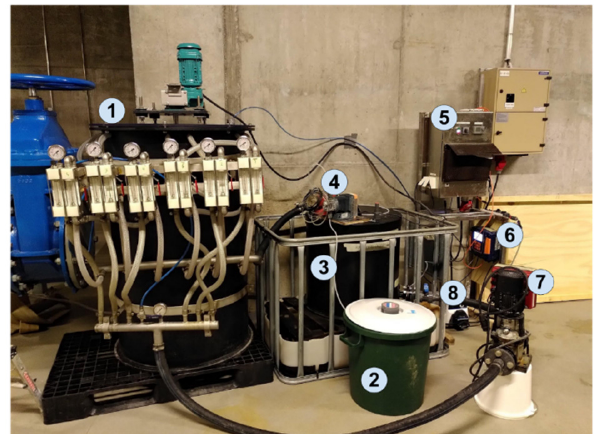
Figure 2. Ämmässuo pilot test set up: (1) membrane reactor, (2) NaOH container, (3) H 2 SO 4 container, (4) NaOH pump, (5) power station, (6) controller DULCOMETER diaLog DACb, (7) H 2 SO 4 pump, and (8) peristaltic pump (Masterflex) controlling the feed flow rate.